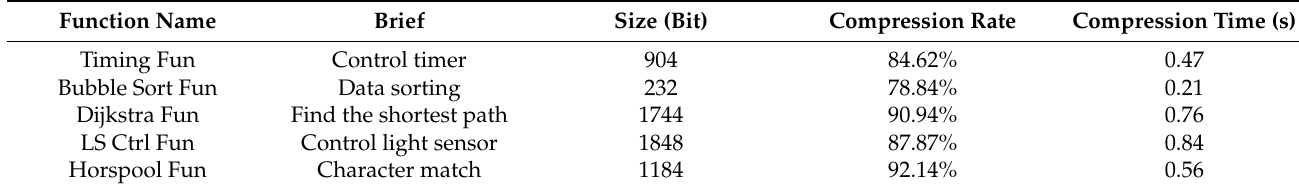
Table 2. Compression